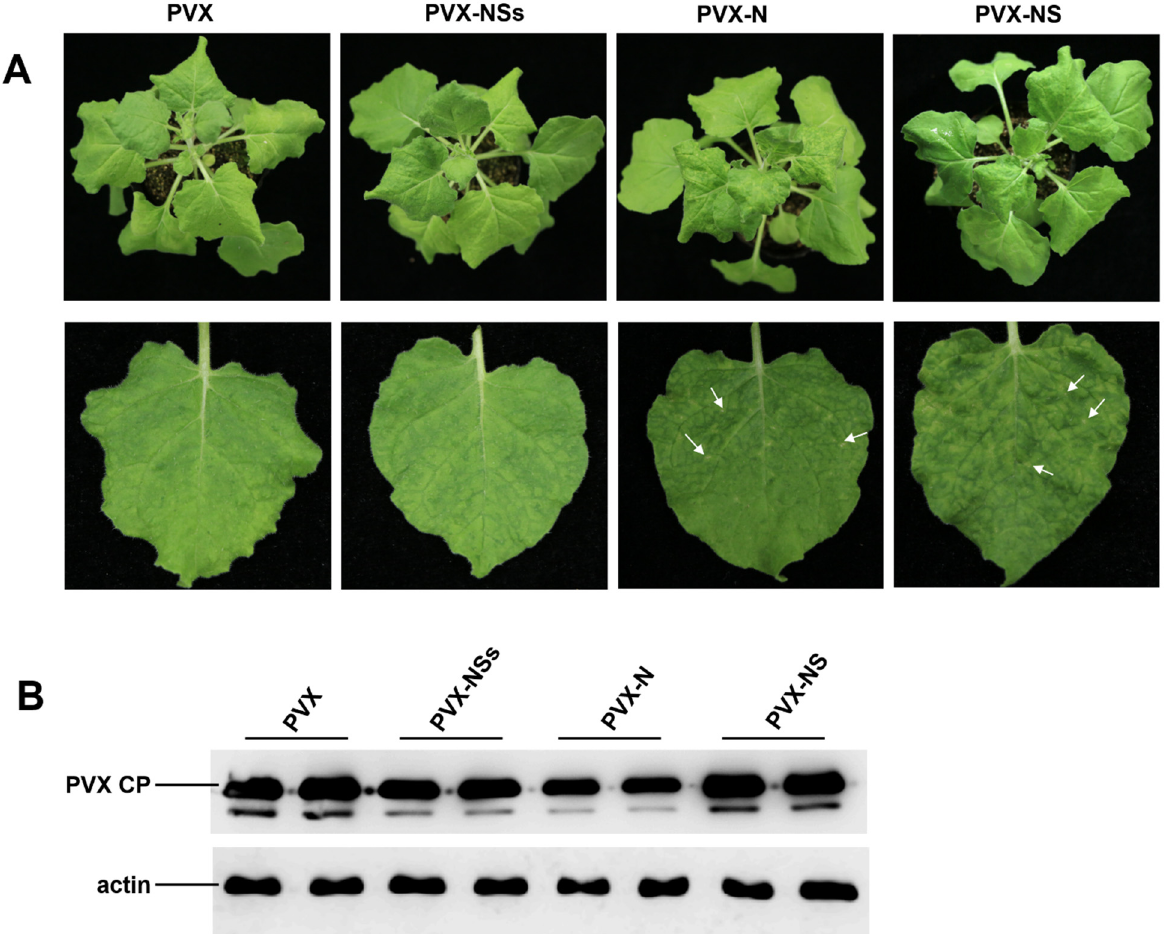
Figure 4. Symptom determinant analysis of RDaBV. ( A ) Heterologous expression of RDaBV NSs, N, and NS proteins. N. benthamiana leaves were infiltrated with A. tumefaciens harboring PVX-NSs, PVX-N, PVX-NS, or PVX construction. White arrows indicate necrotic patches. ( B ) Western blot analyzing PVX accumulation levels in N. benthamiana leaves. Actin was used as an internal reference.